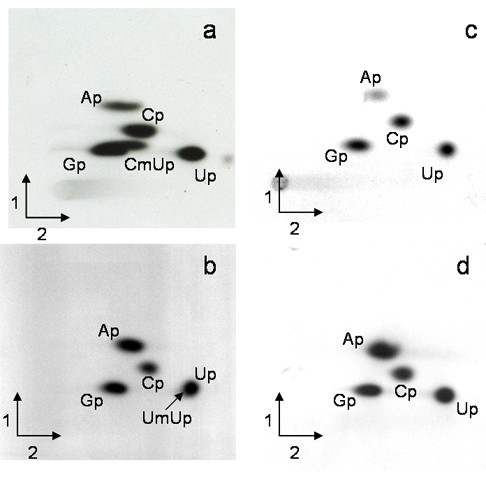
RNAse T2 cleavage of in vitro transcribed E. coli tRNASer1 and tRNAGln2 incubated with YfhQ and AdoMet. Autoradiography of two-dimensional chromatograms of 5'-phosphate and 3'-phosphate nucleosides on thin layer cellulose plates. [α-32P]UTP-labelled in vitro transcribed tRNASer1 (2.5 × 105 cpm) (a and c) and [α-32P]UTP-labelled in vitro transcribed tRNAGln2 (2.5 × 105 cpm) (b and d) was incubated in the presence (a and b) or absence (c and d) of the YfhQ protein. The reaction mixture contained 50 mM PIPES-Na, pH 7.0, 4 mM MgCl2, 50 μM AdoMet and 5 μg of the purified YfhQ protein. After 90 min incubation at 37°C, the tRNA was recovered, cleaved by RNAse T2, the resulting nucleotides were analyzed as described [38].